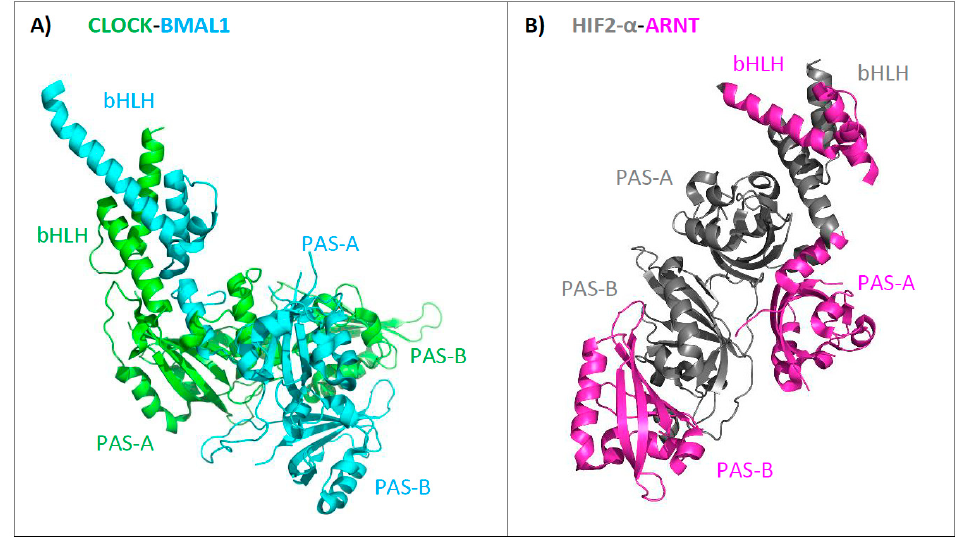
Figure 4. Representatives of the two groups of the bHLH–PAS heterodimers. ( A ) Overall structure of the CLOCK-BMAL1 heterodimer (4f3l, [47]), ( B ) overall structure of the HIF2- α –ARNT heterodimer (4zp4, [48]).